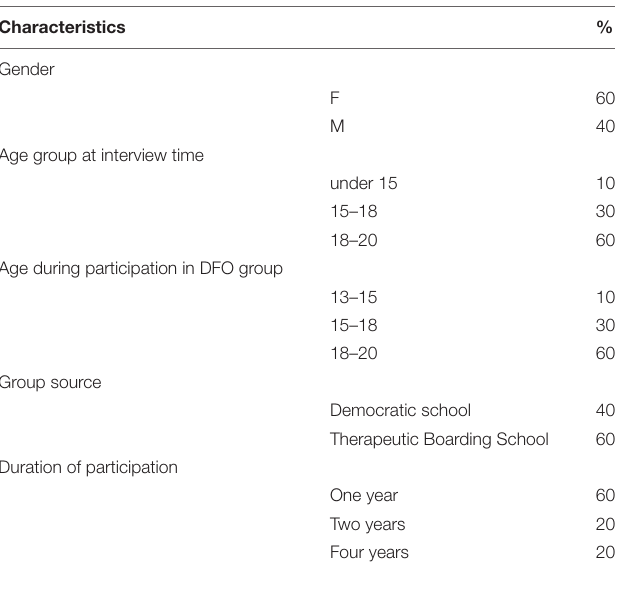
TABLE 2 | Participants’ demographics ( N =